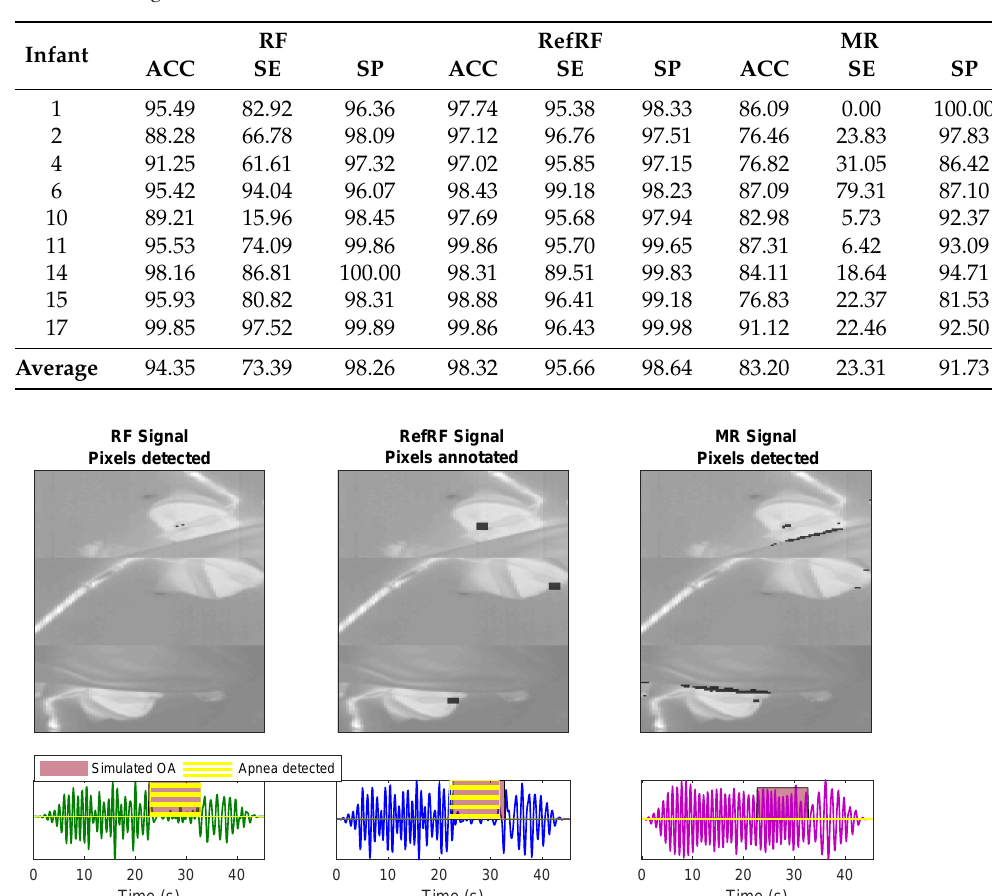
Table 3. Accuracy, sensitivity, and specificity of the OA detection for the RF signal , the RefRF signal , and the MR signal .